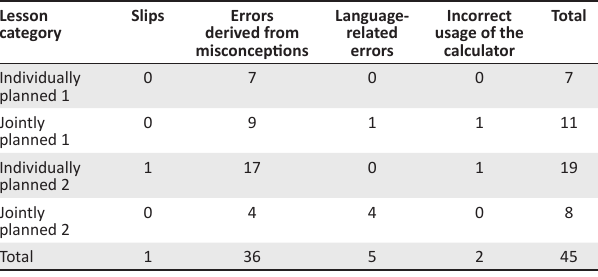
TABLE 3: Number of different kinds of mistakes dealt with by the teacher. Lesson category